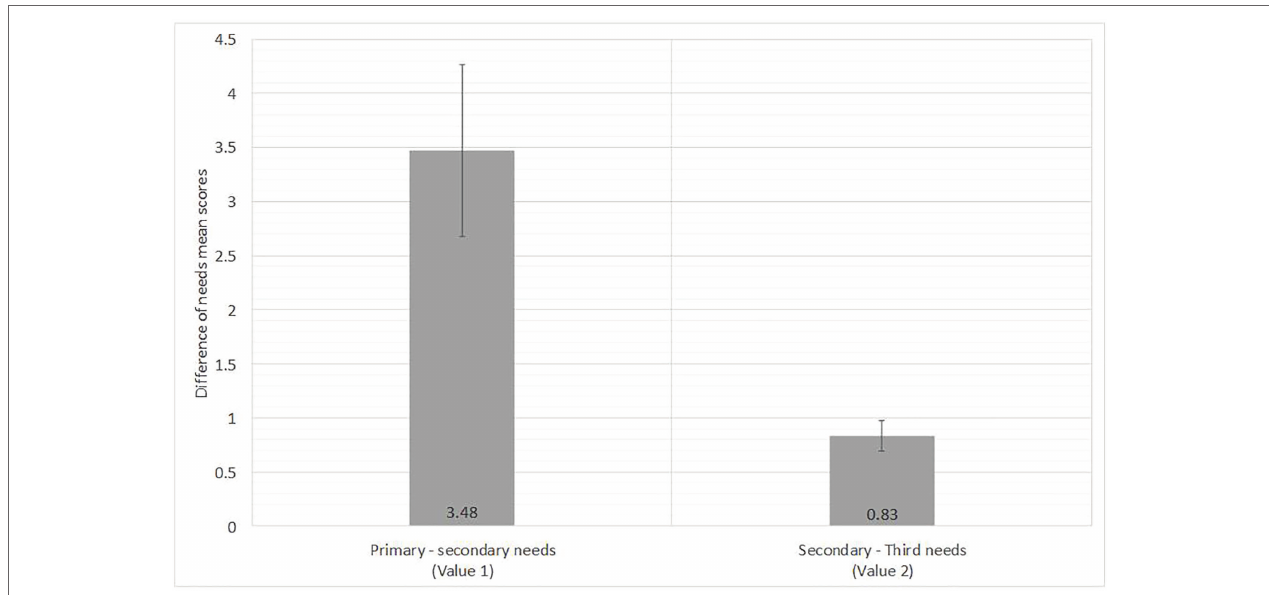
FIGURE 3 | Difference test mean values of top-3 needs of